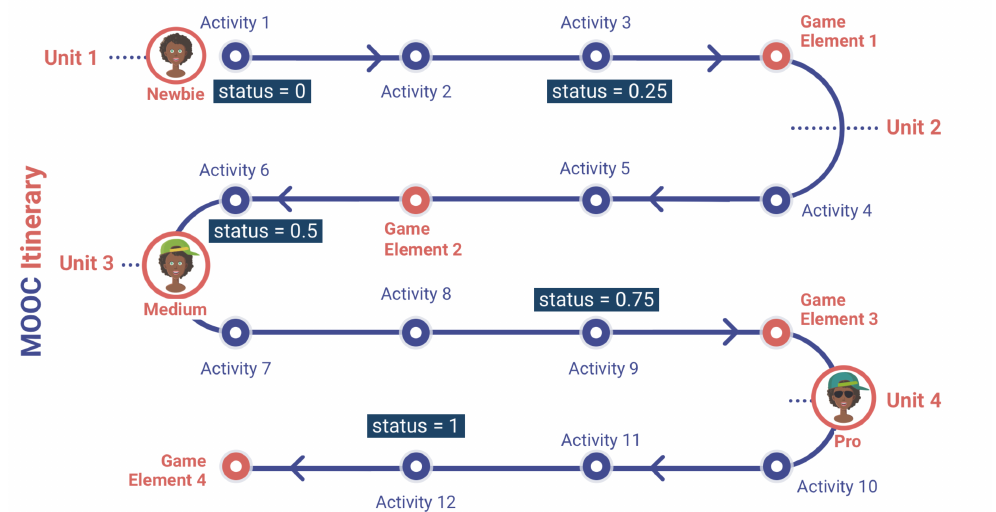
Figure 2. Gamified MOOC itinerary: students’ statuses are depicted from 0 to 1 relying on the Learning Activities (Newbie, Medium, and Pro avatars are shown in different parts of the itinerary). Game Elements (GE) between activities are displayed using small red circles. We developed a new XBlock in the edX platform able to add a Game Element to the MOOC itinerary; see video Adding a Game element Xblock in edX, accessed on 12 January 2023.